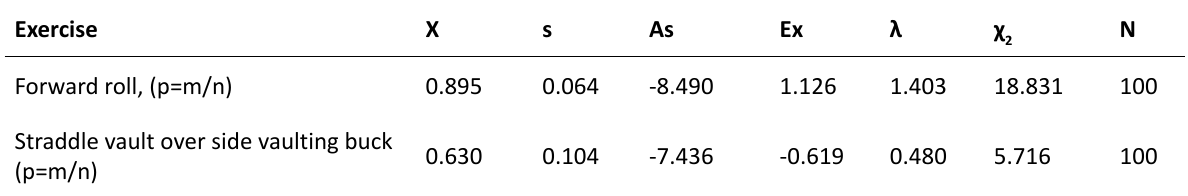
Table 6. Computational experiment results. Elementary statistics. Boys aged 8-9 years Exercise Forward roll,